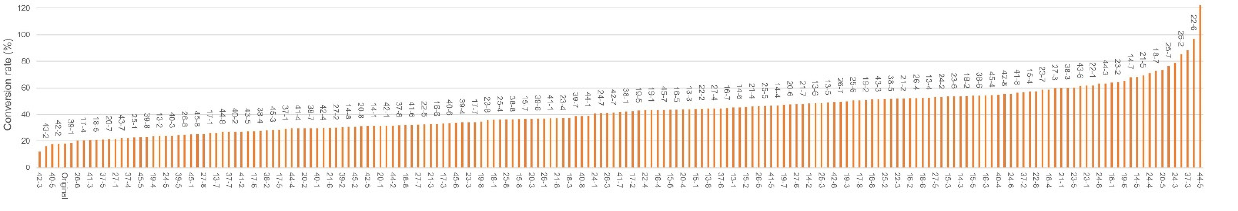
Figure 2. Conversion rate (%, ■ ) from tomatine to esculeoside A in each tomato sample. Table 4. Content of two triterpenoid glycosides ( μ g/g of fresh weight) in the mutant lines with higher tomatine content compared with the original cultivar among unripe green fruits of mutant tomato